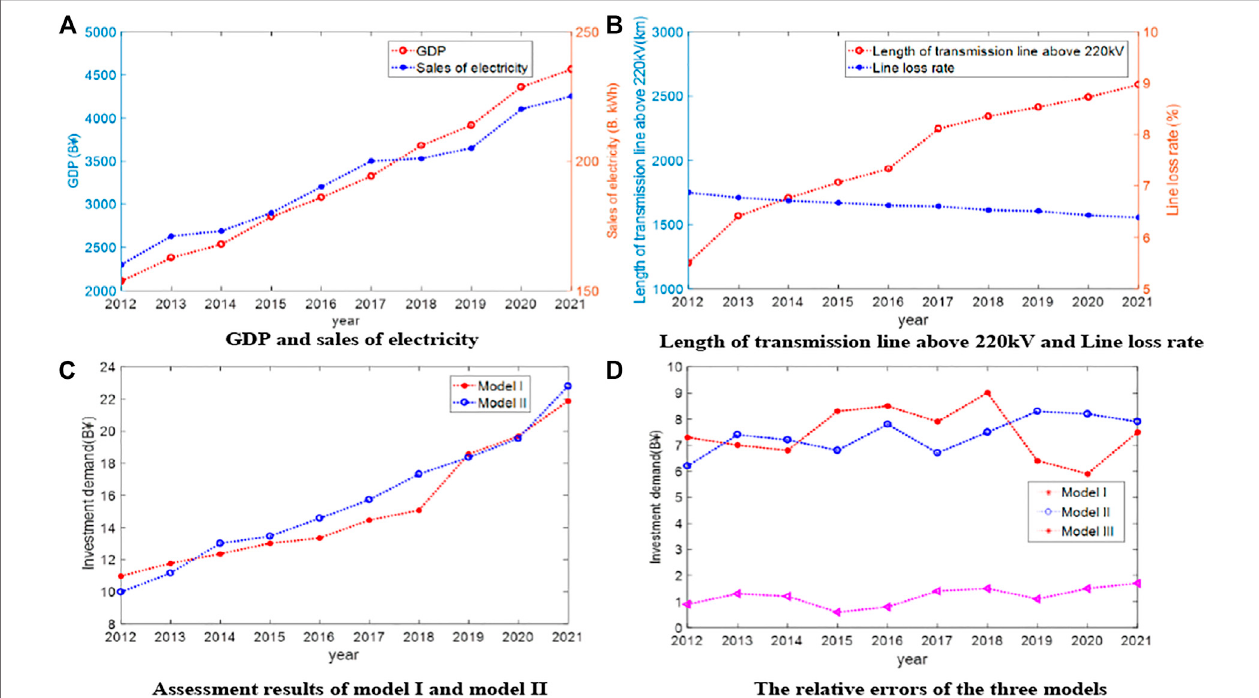
FIGURE 3 | Input parameters and comparative results of three assessment models.